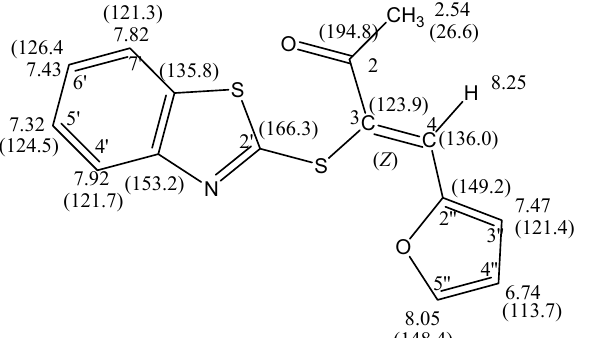
Figure 6. The complete assignment of H 1 and 13 C chemical shifts for 6 based on the COSY and HSQC